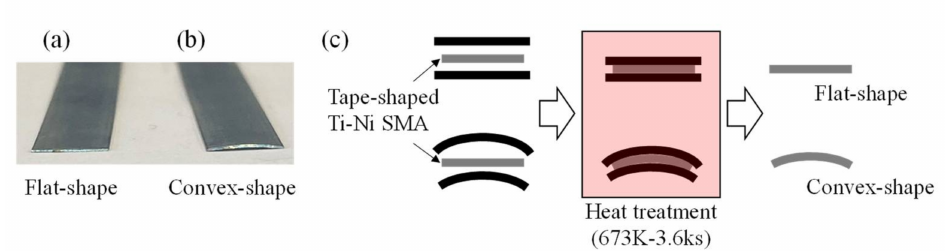
Figure 3. The ( a ) flat tape-shaped and ( b ) convex tape-shaped Ti-Ni SMA elements fabricated in this study; and ( c ) the schematic drawing of the heat treatment method for producing tape-shaped Ti-Ni SMA elements.